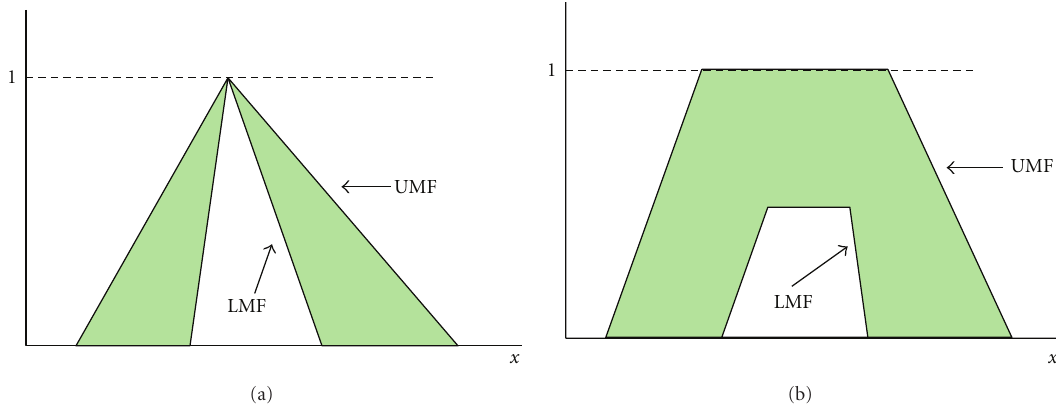
Figure 4: The membership function of an interval type 2 fuzzy set [1].